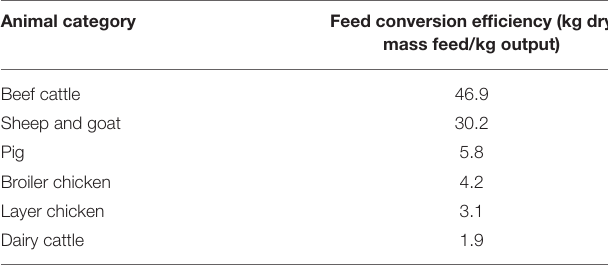
TABLE 1 | Global average feed conversion efficiency per animal category and production system. Animal